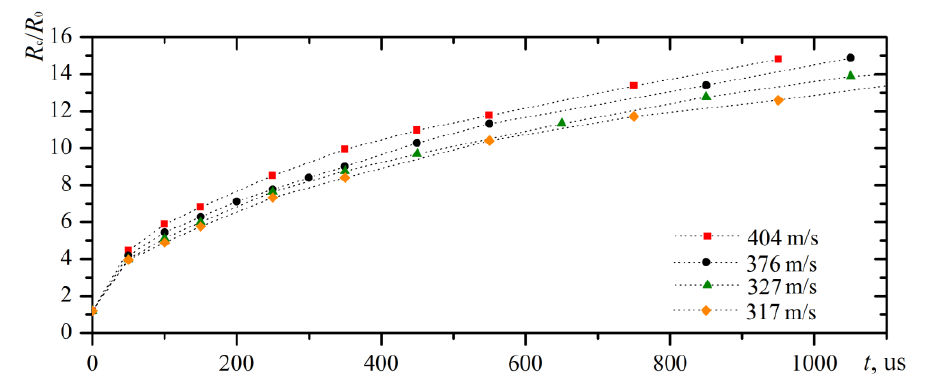
Fig. 3. Expansion of undisturbed cavity section versus time for different bodies speeds (initial period).